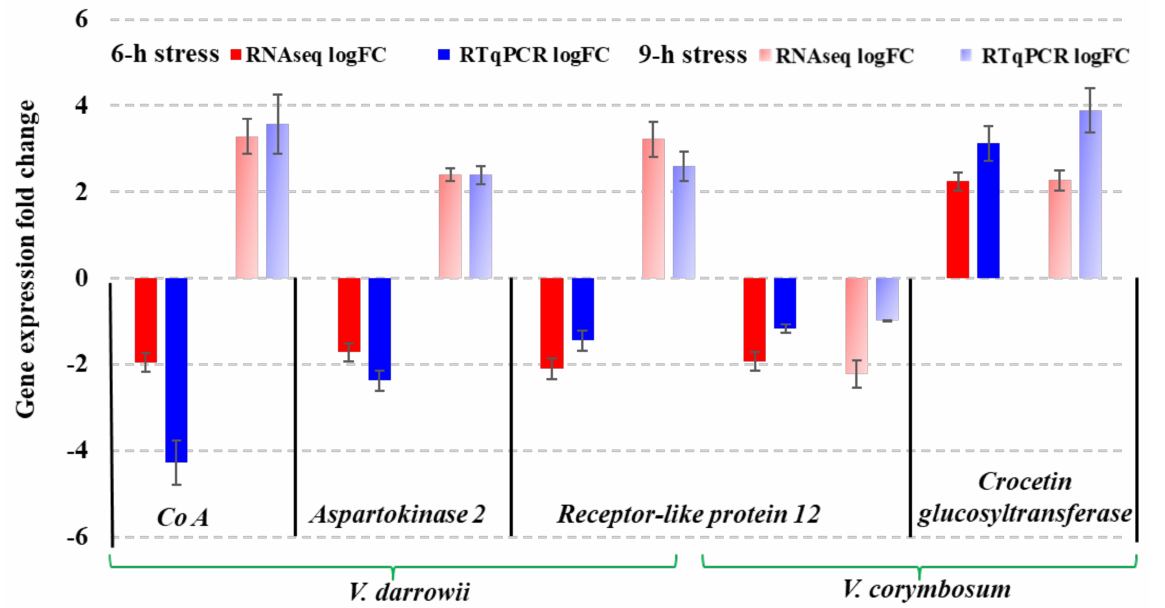
Figure 8. RT-qPCR validation of DEGs: Gene expression patterns of randomly selected genes in both blueberry species ( V. darrowii and V. corymbosum ) at 6- and 9-h heat